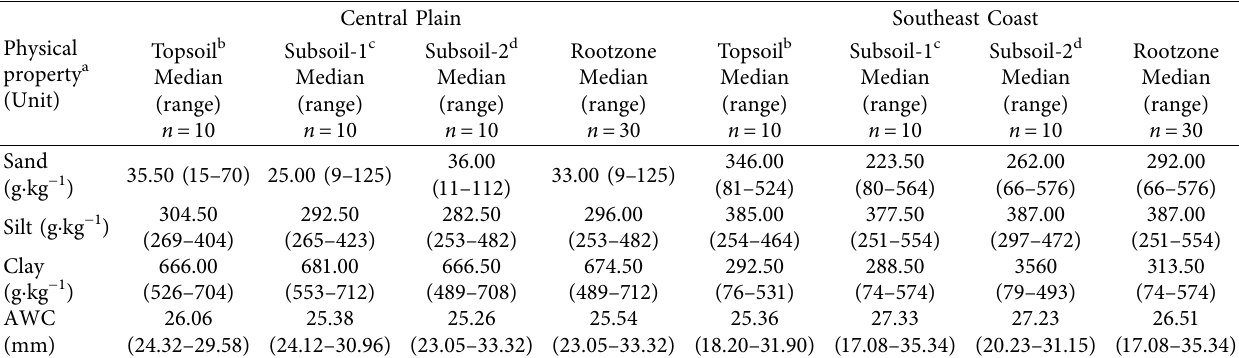
Figure 3: Water deficit suitability classification (WD � annual water deficit) and ideal climate requirement (MaxT � annual maximum temperature; MinT � annual minimum temperature) for oil palm of acid sulfate soils under oil palm planting areas in Central Plain and Southeast Coast, Thailand. Table 6: Physical properties of acid sulfate soils under oil palm planting areas in Central Plain and Southeast